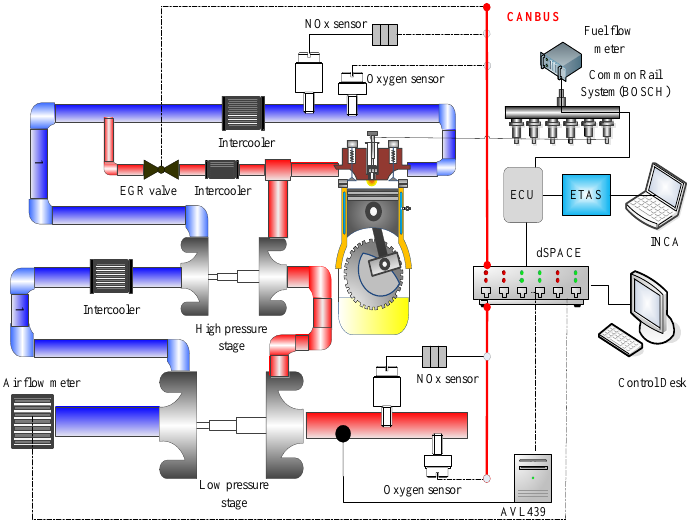
Figure 1. Schematic diagram of transient measurement and control platform.